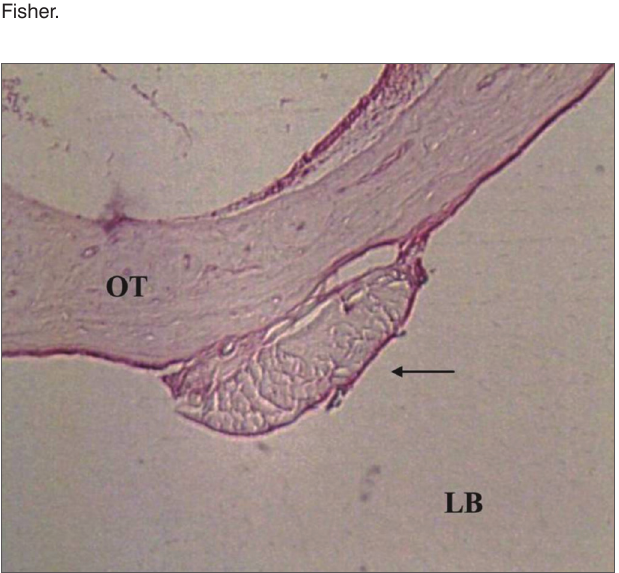
Figura 6. Sinais de absorção do biomaterial - Fotomicrografia da desorganização estrutural da membrana do biopolímero da cana-de- açúcar e sua absorção parcial, observada na bula timpânica com 8 semanas. BP= biopolímero da cana-de-açúcar; seta larga= exsudato inflamatório. HE (aumento de 40x)